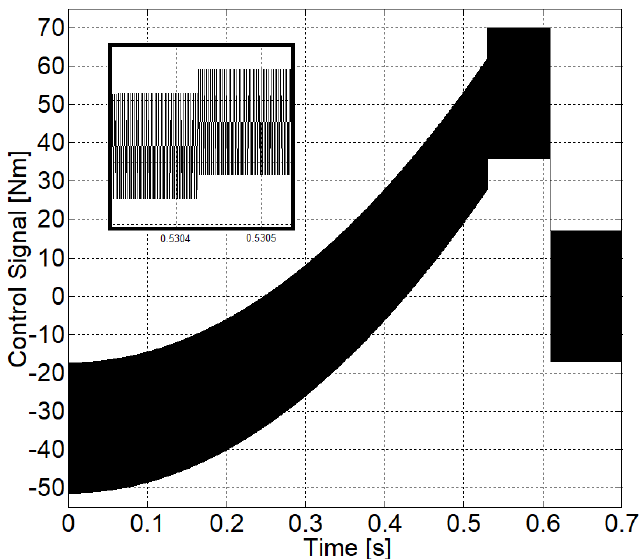
Figure 10. Control signal with both input and velocity